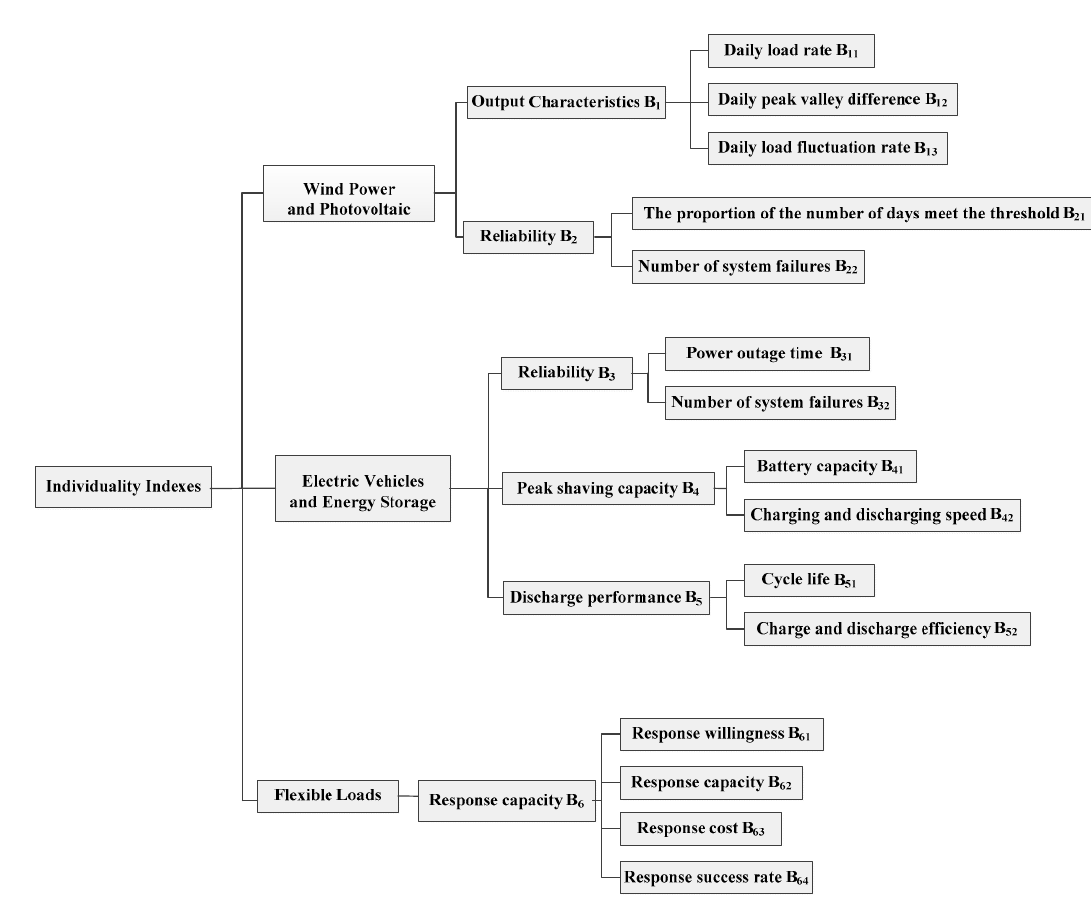
Figure 3. The framework of the individuality indexes.